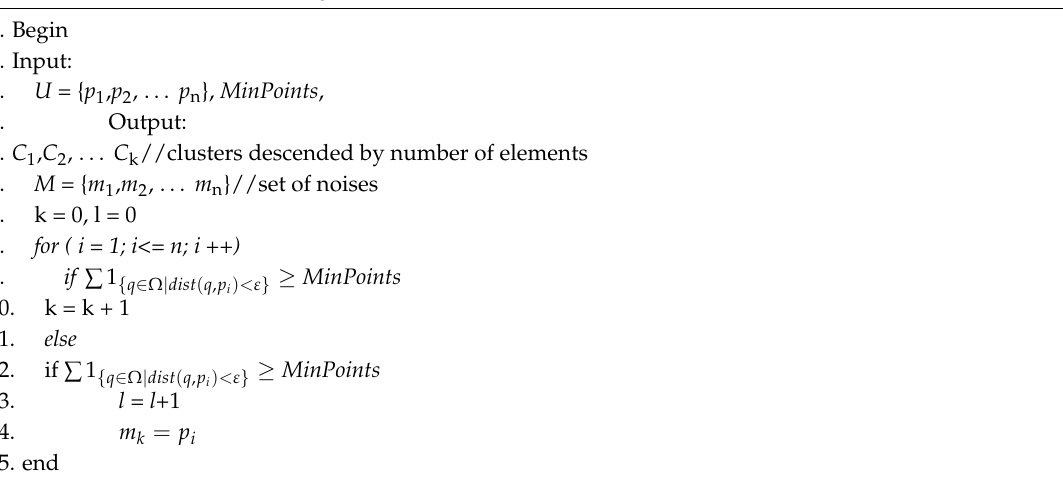
Algorithm 1. DBSCAN Clustering